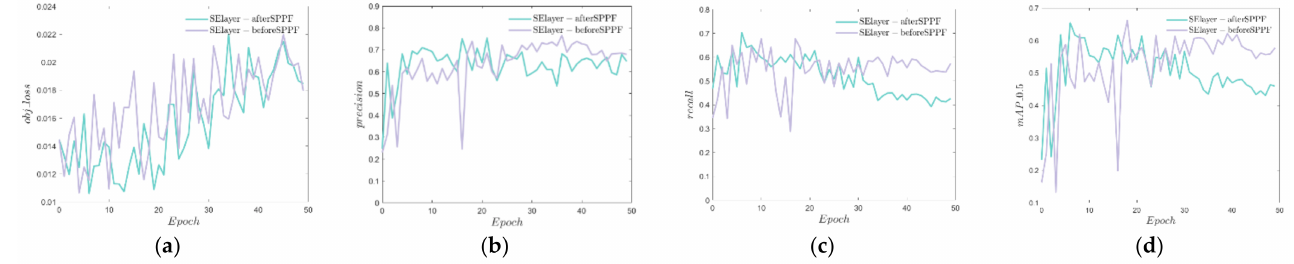
Figure 14. SE module position comparison result. ( a ) Target loss. ( b ) Accuracy rate. ( c ) Recalling rate. ( d ) mAP